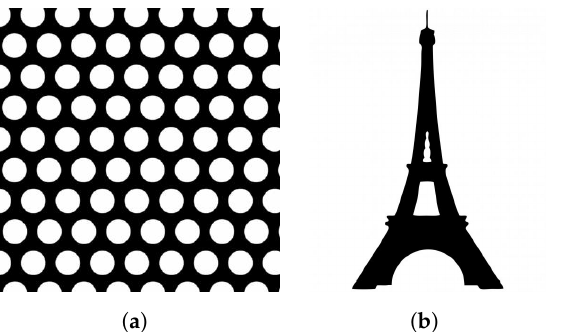
Figure 3. Reference design inputs for examples include ( a ) circular mesh and ( b ) Eiffel